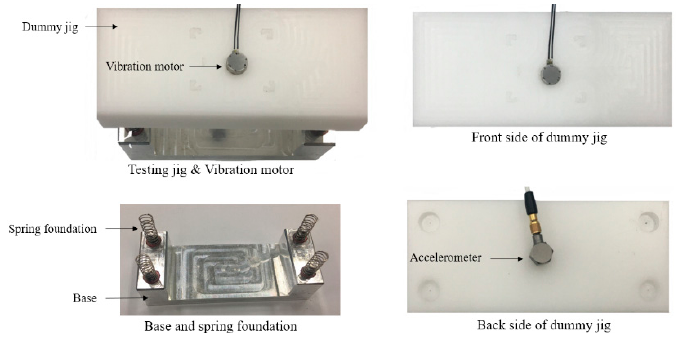
Figure 14. The detailed components of the acceleration testing jig.